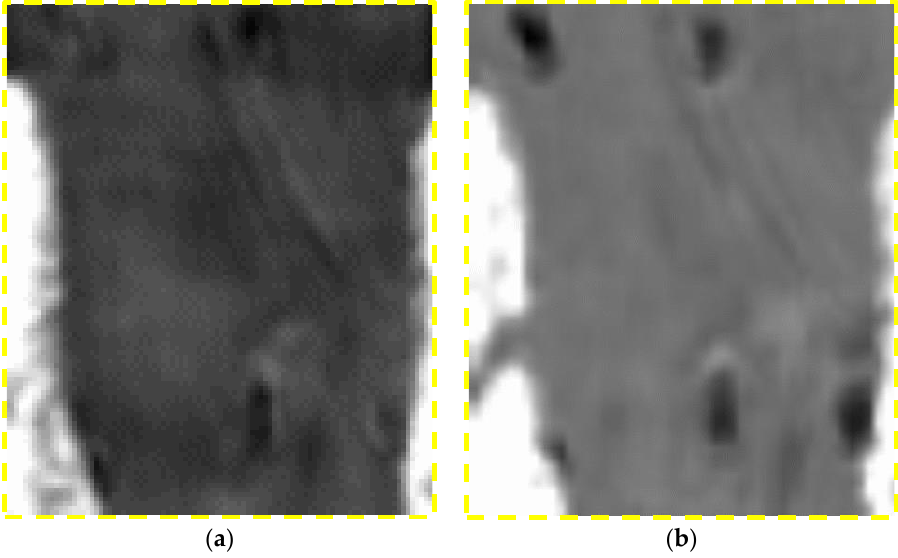
Figure 31. HSR images of the Croce di San Marco recorded at 3.7 GHz: ( a ) parallel polarization and ( b ) cross-polarization.